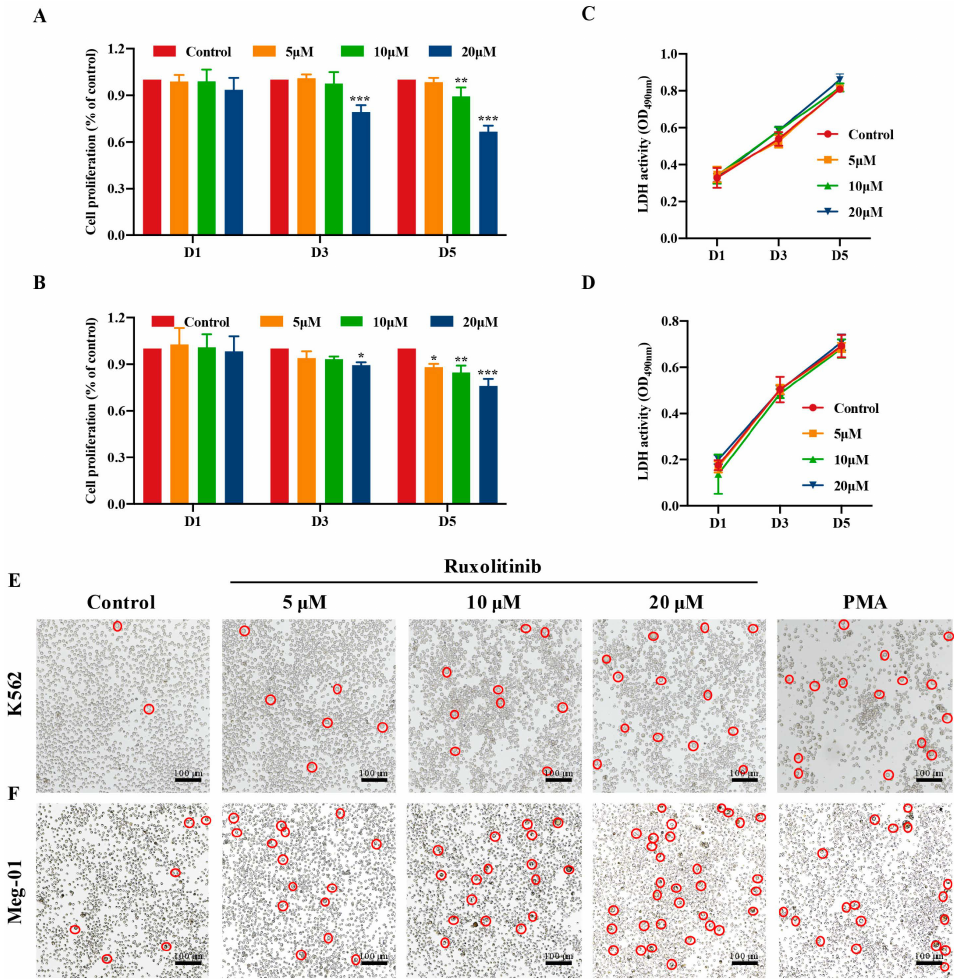
Figure 1. Safe concentration of ruxolitinib for treatment of K562 and Meg‑01. ( A , B ) The effect of Ruxolitinib intervened on MKs proliferation. Different time points and concentrations on the pro‑ liferation rate (%) of megaryocytes. Results of the CCK‑8 assay for K562 and Meg‑01 cells prolifera‑ tion; ( C , D ) The LDH release of ruxolitinib intervened K562 and Meg01 cells at different time points; ( E , F ) Representative images of K562 and Meg‑01 cells treated with various concentrations of Ruxoli‑ tinib (5, 10, and 20 µ M) for 5 days. The positive control is PMA (2.5 nM). n = 3, * p < 0.05, ** p < 0.01, *** p < 0.001, vs.